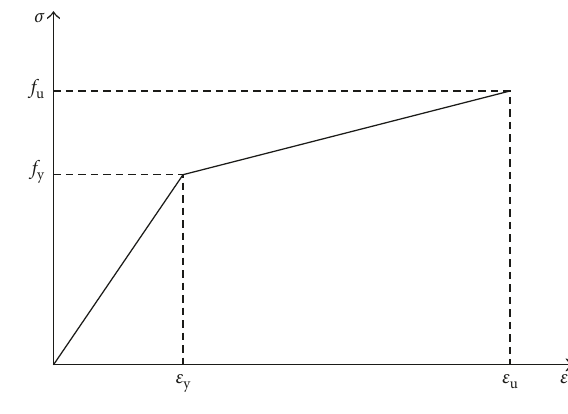
Figure 4: Stress-strain curve of the steel bar.